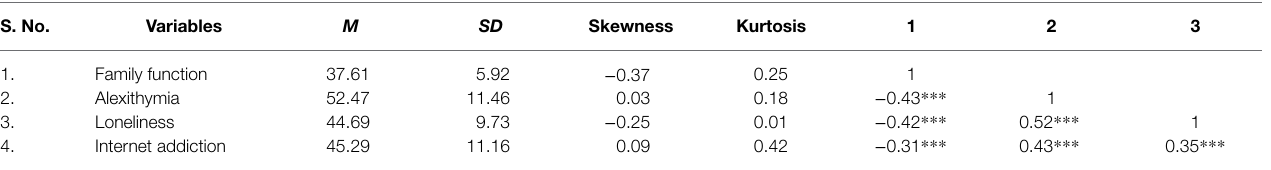
TABLE 1 | Descriptive statistics and correlations among